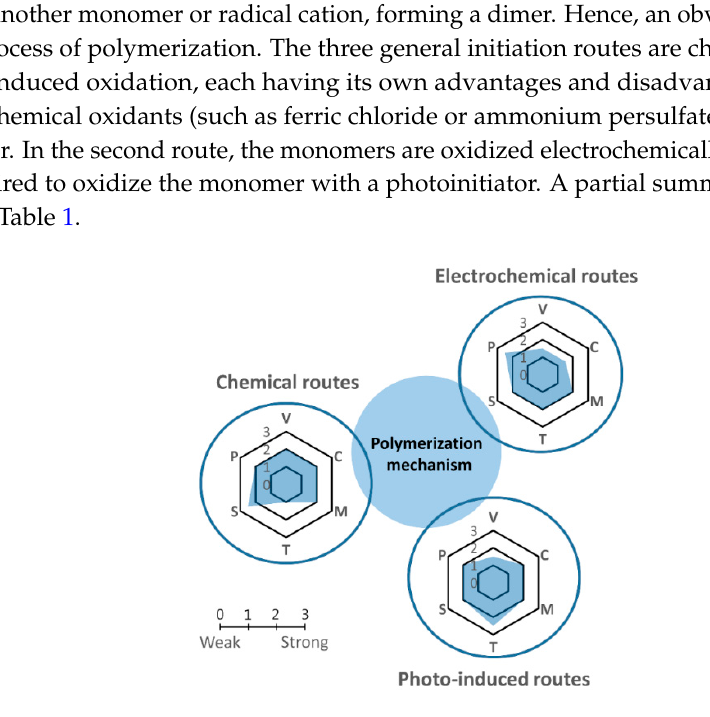
Figure 3. Schematic comparing the chemical, electrochemical, and photopolymerization mechanisms. Each method has been evaluated in term of variables (V), in which a low value means there are many key variables in the synthesis process; cost effectiveness (C), in which a low value corresponds to high cost; morphology control (M); time of reaction (T); scalability (S); and the resulting purity (P) of the materials. Table 1. Polymerization routes employed to obtain conducting polymers (CPs). Route